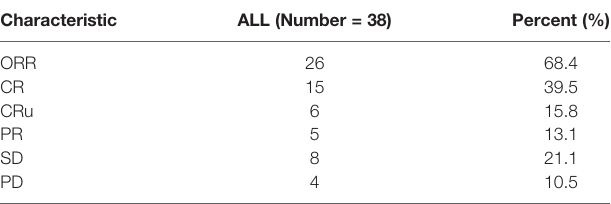
TABLE 2 | Treatment ef fi cacy observation (N = 38).